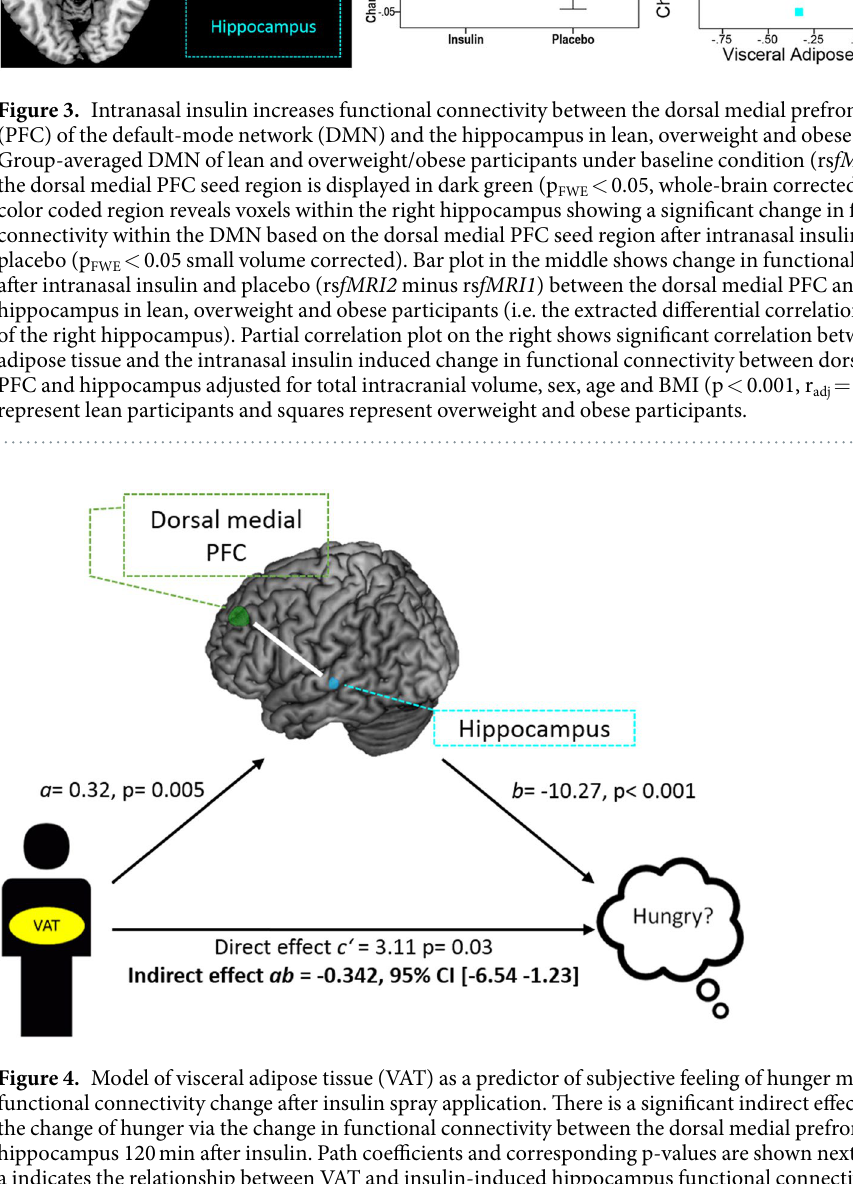
ing of hunger. Participants with a stronger increase in functional connectivity felt less hungry 120 minutes after